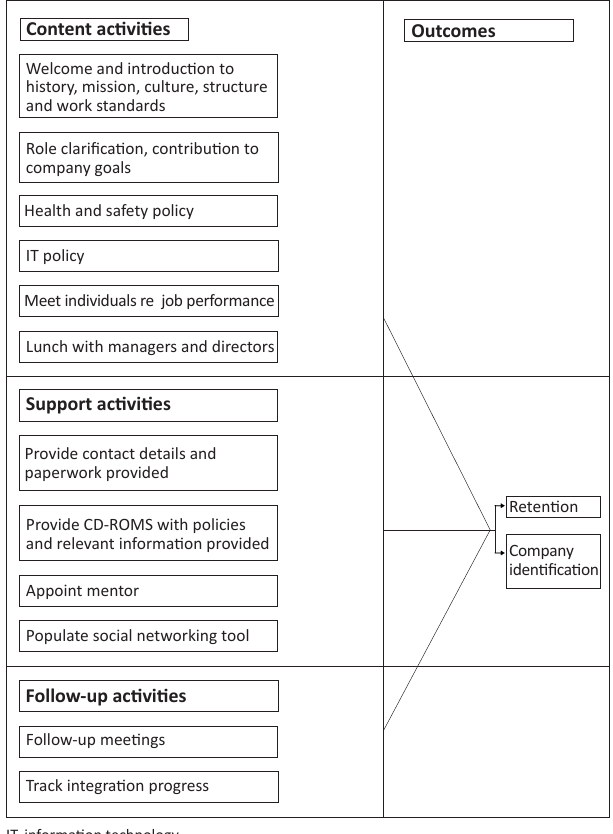
FIGURE 4: Ideal programme activities for induction